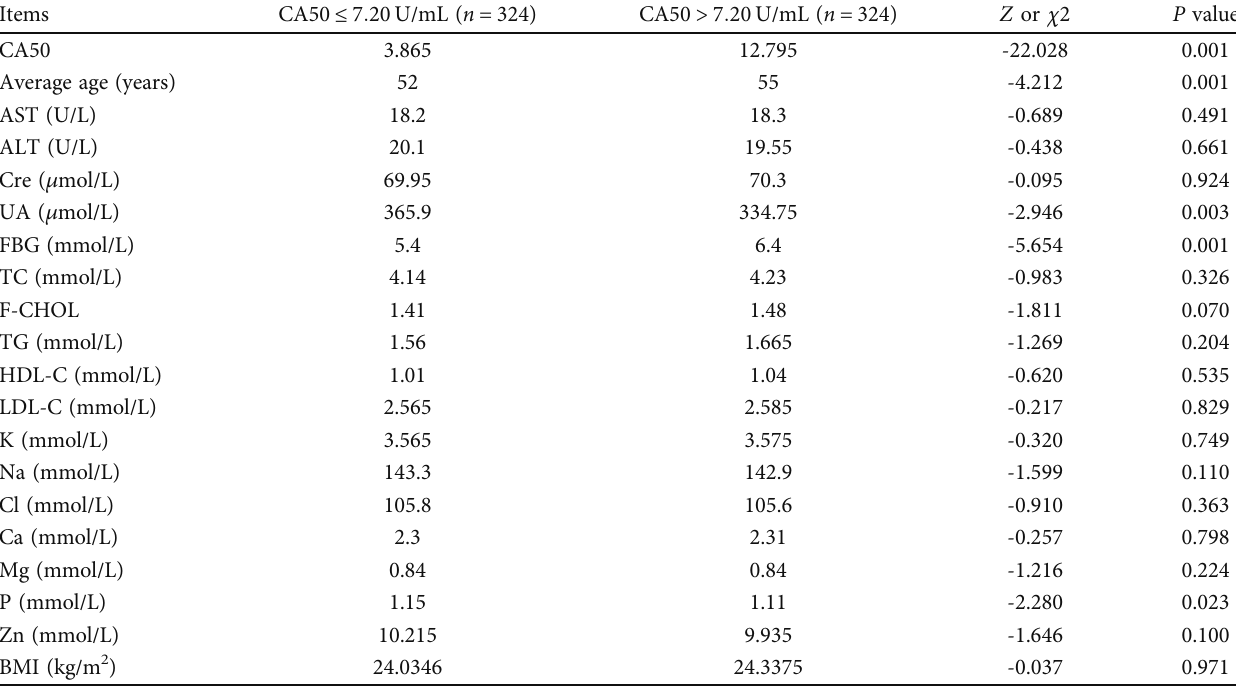
Table 8: Comparison of clinical data of patients in the CA50 ≤ 7 : 20 U/mL and CA50 > 7 : 20U/mL